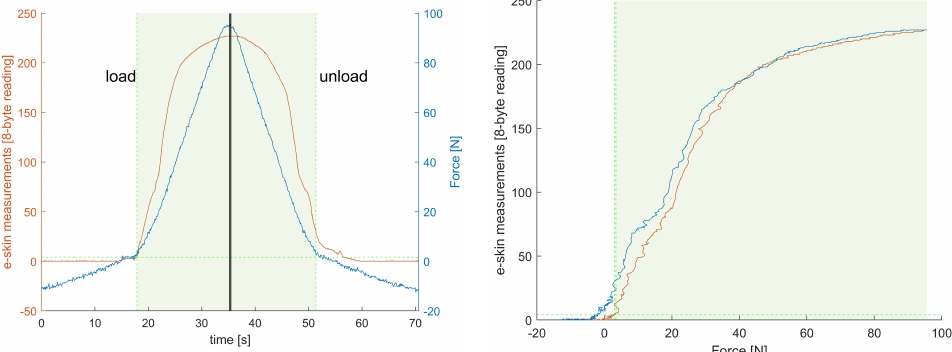
Figure 13. Data recorded while taking measurements from one of the e-skin sensors (row 7, col- umn 26). The markings on the left graph are analogous to those in Figure 9 and on the right graph are analogous to those in Figure 10.